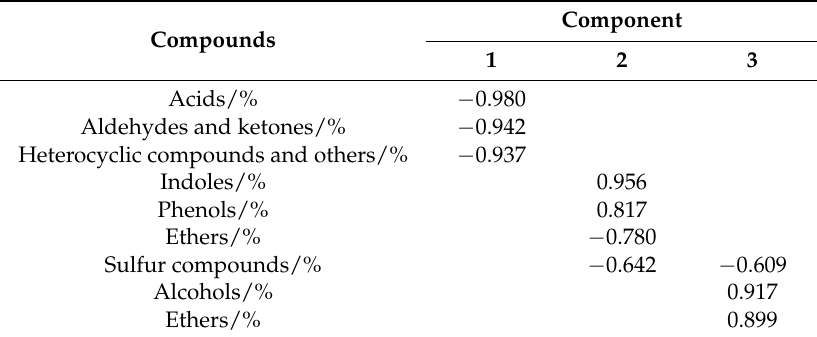
Table 3. Rotational component